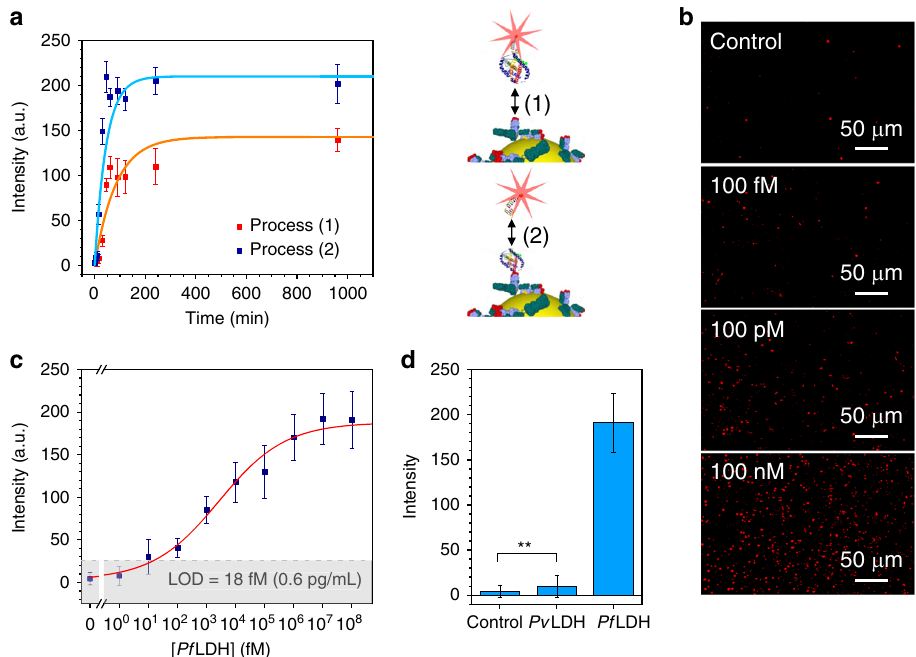
Fig. 4 Fluorescence-based immunoassay. a Kinetic curves related to (1) Ab-analyte and (2) analyte-aptamer binding dynamics. Both processes reach their equilibrium in a short time by incubation and tilting mixing (80 min and 45 min, respectively). The time difference is ascribable to the signi fi cantly larger Pf LDH mass. The data are well fi tted by exponential curves (orange and blue continuous lines). b Fluorescence images acquired at different Pf LDH concentrations in spiked human blood. c Calibration curve ( fl uorescence intensity vs Pf LDH concentration in spiked human blood) of the immunoassay for Pf LDH concentration in the range 1 fM to 100 nM (35 fg/mL to 3.5 μ g/mL). The data are best fi tted by the four-parameter Hill equation (red solid line). The gray region represents the 3 σ noise level recorded in uncontaminated human blood (LOD = 18 fM (0.6 pg/mL)). d Speci fi city of the immunoassay against Pv LDH (90% residue identity with Pf LDH) at a concentration of 100 nM in spiked human blood. No cross-reaction detected with the main Pf LDH competitor highlights the extremely high speci fi city of the aptamers used as top bioreceptor layer (** p -value < 0.001). All the data underlying averaged value are presented as mean value ± SD and are representative of ten technical repeats. Source data are provided as a Source data fi